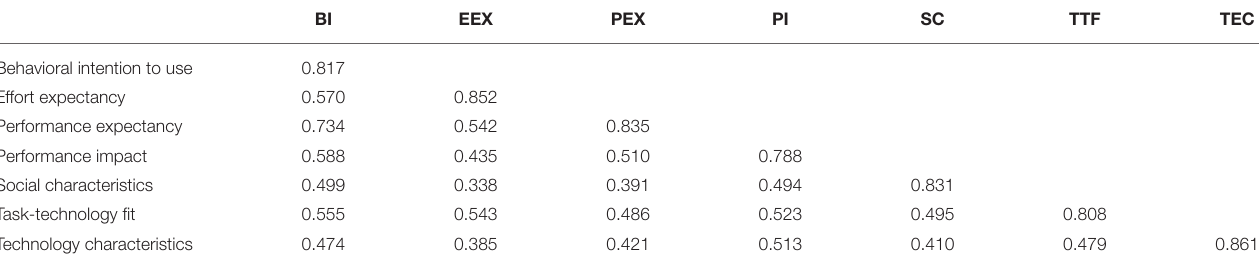
TABLE 4 | Fornell-larcker criterion.